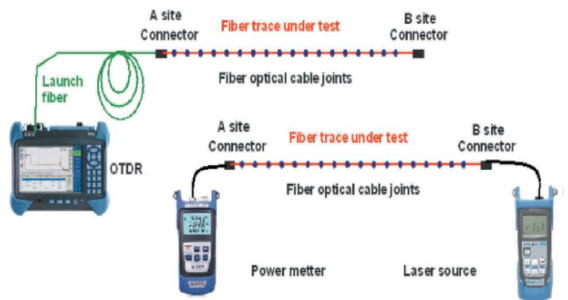
Figure 1. Presentation of the measurement model of a practical transmission system, i.e. measurement on an installed optical